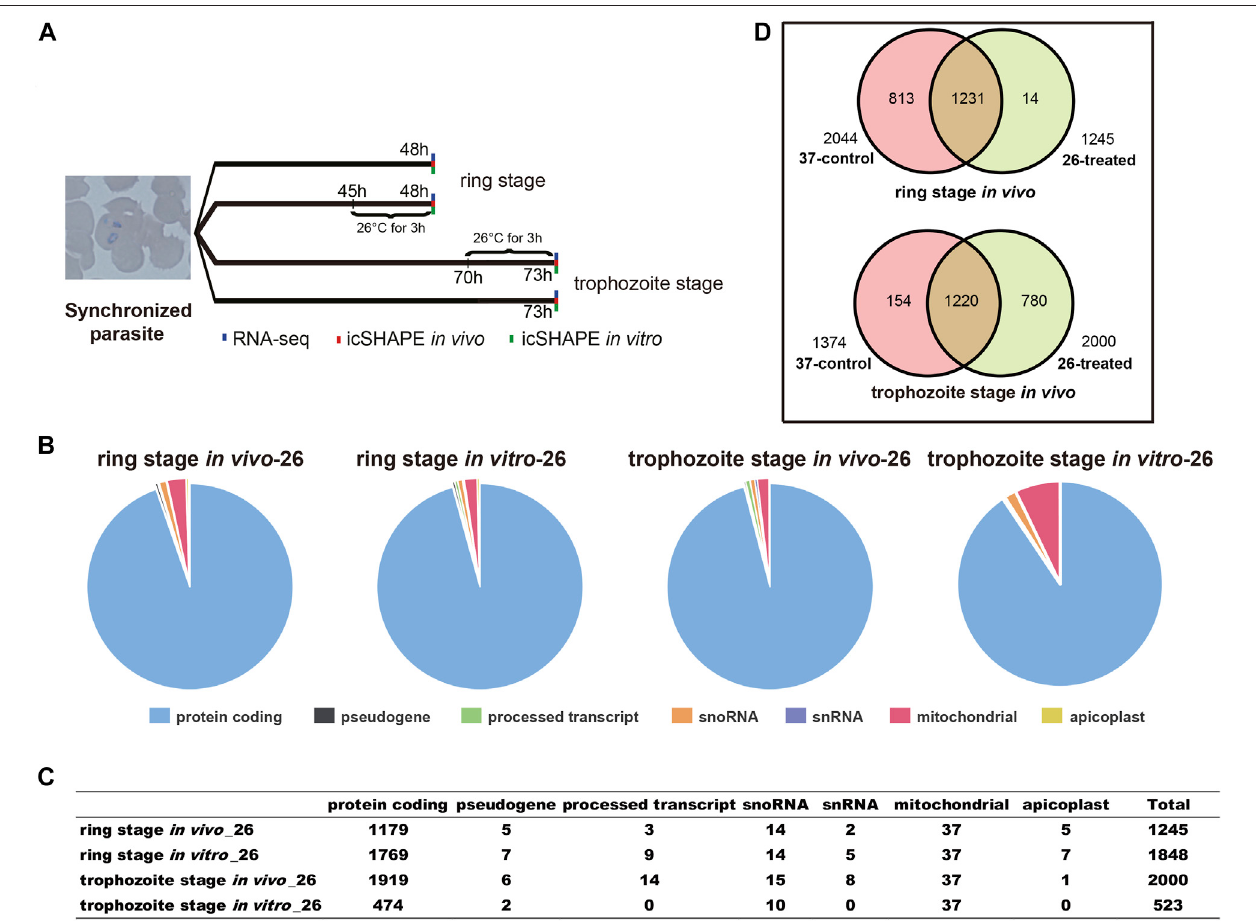
FIGURE1| ExperimentaldesignandicSHAPElibrarystatistics. (A) OverviewoftheicSHAPEapproachinourexperiment. Weperformedtemperaturestress(37 ° C and26 ° C)totheculturedparasitesat45 h(ringstage)/70 h(trophozoitestage)andcontinuetocultureatdifferenttemperaturesforcontinuous3 h. Invivo RNAstructure experiments, in vitro RNA structure experiments, and RNA-seq experiments were performed for all four groups. (B, C) The number of RNA structural pro fi les for the wholetranscriptswasclassi fi edintovariousclassesofRNAsfrom1,245transcriptsforringlibraryat26 ° C invivo ,2,000transcriptsfortrophozoitelibraryat26 ° C in vivo ,1,848transcriptsforringlibraryat26 ° C invitro ,and523transcriptsfortrophozoitelibraryat26 ° C invitro . (D) OverlapofmRNAsbetween37 ° Cand26 ° Camongthe two different stages in vivo .